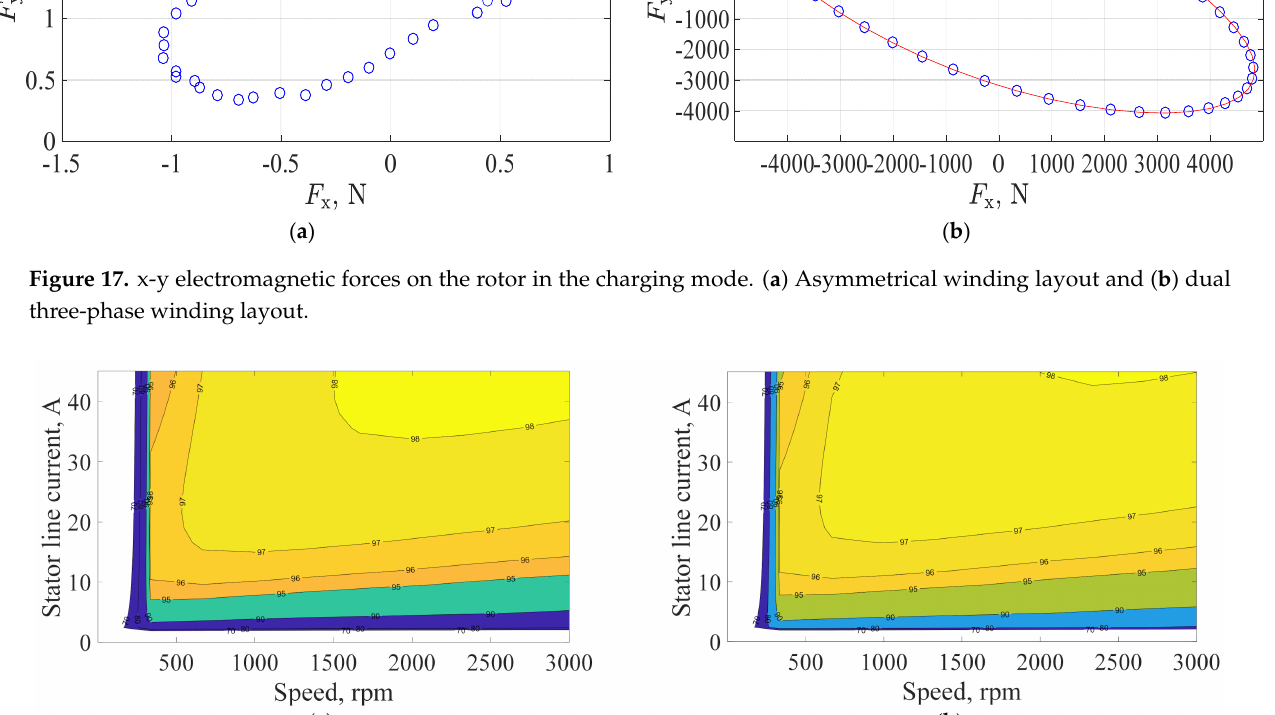
Figure 18. Efficiency maps. ( a ) Asymmetrical winding layout and ( b ) dual three-phase winding